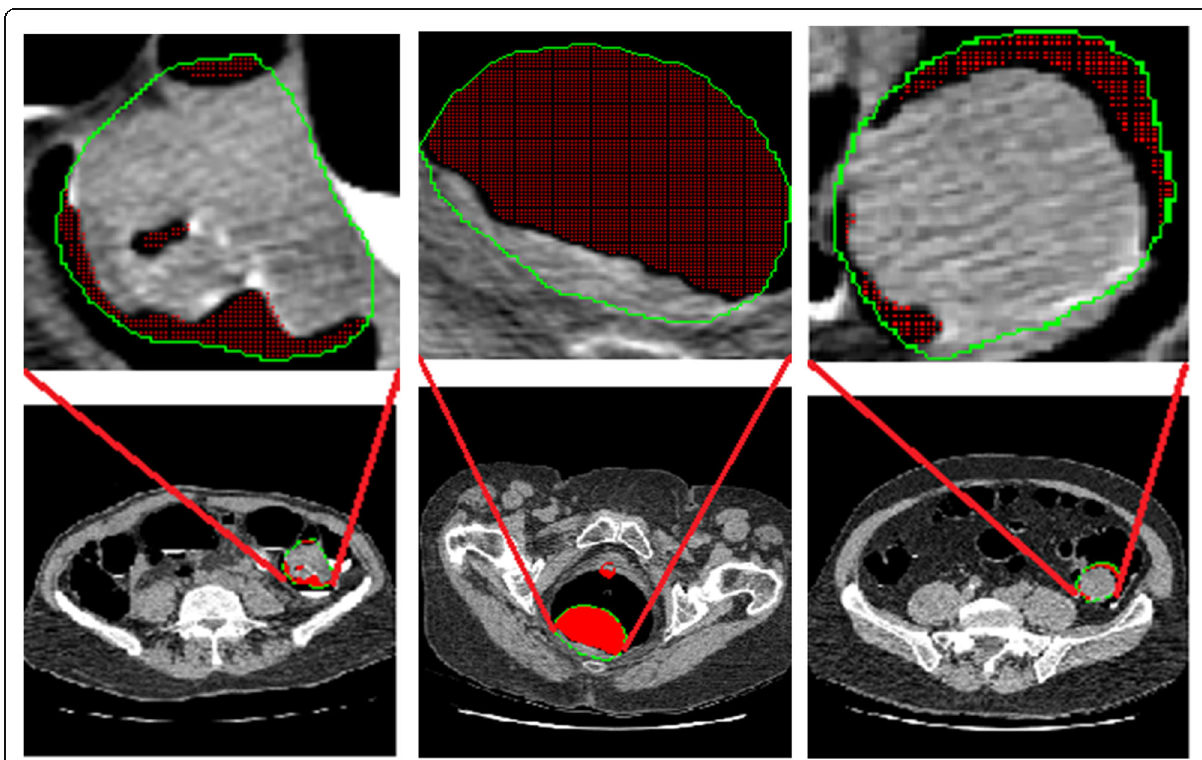
Fig. 1 Polyp heterogeneity and texture in computed tomographic colonography. The green curves are their boundaries plotted by radiologists. The air in polyp is labeled by red